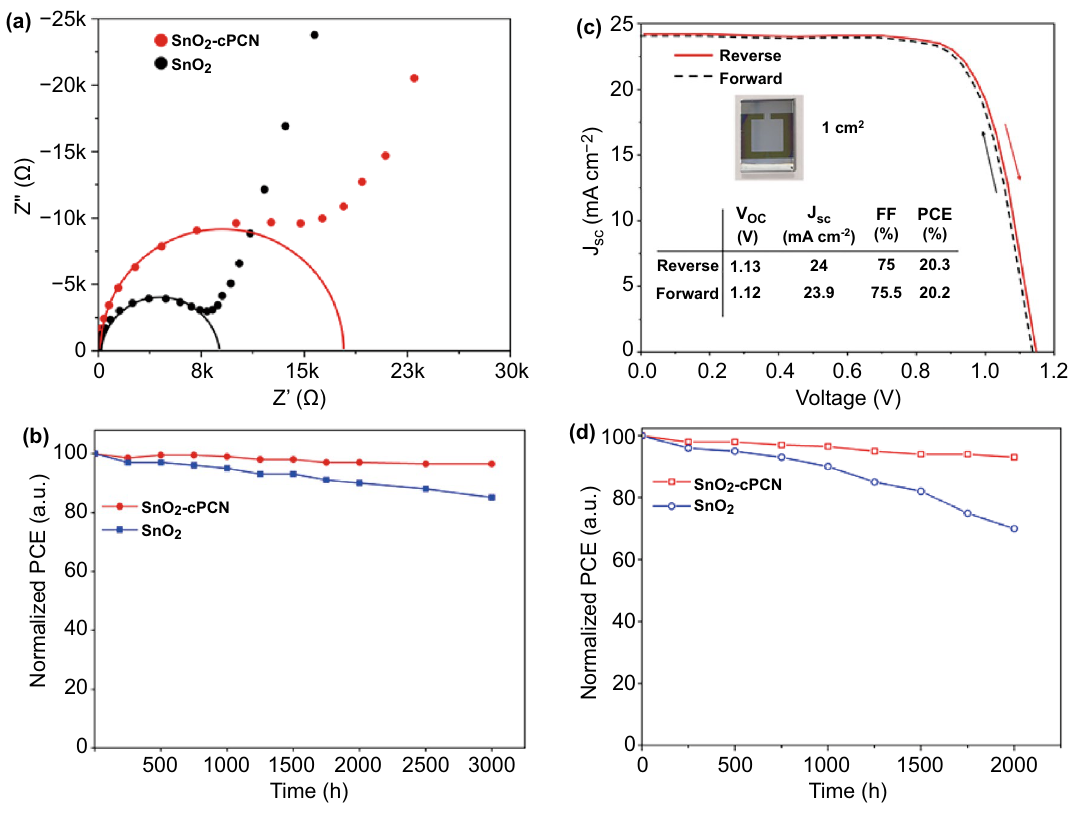
Fig. 6 a EIS of planar-type PSCs with SnO 2 and SnO 2 -cPCN ETL, the insert picture is the fitting model. b J–V characteristics of the SnO 2 -cPCN and SnO 2 based devices with a 1 cm 2 area (active area) in forward and reverse scan; the inset is a picture of real 1 cm 2 area devices. c Long-term stability measurements of devices without any encapsulation under N 2 glovebox, and d Humidity and oxygen stability under an ambient condition (relative humidity: 30% ±